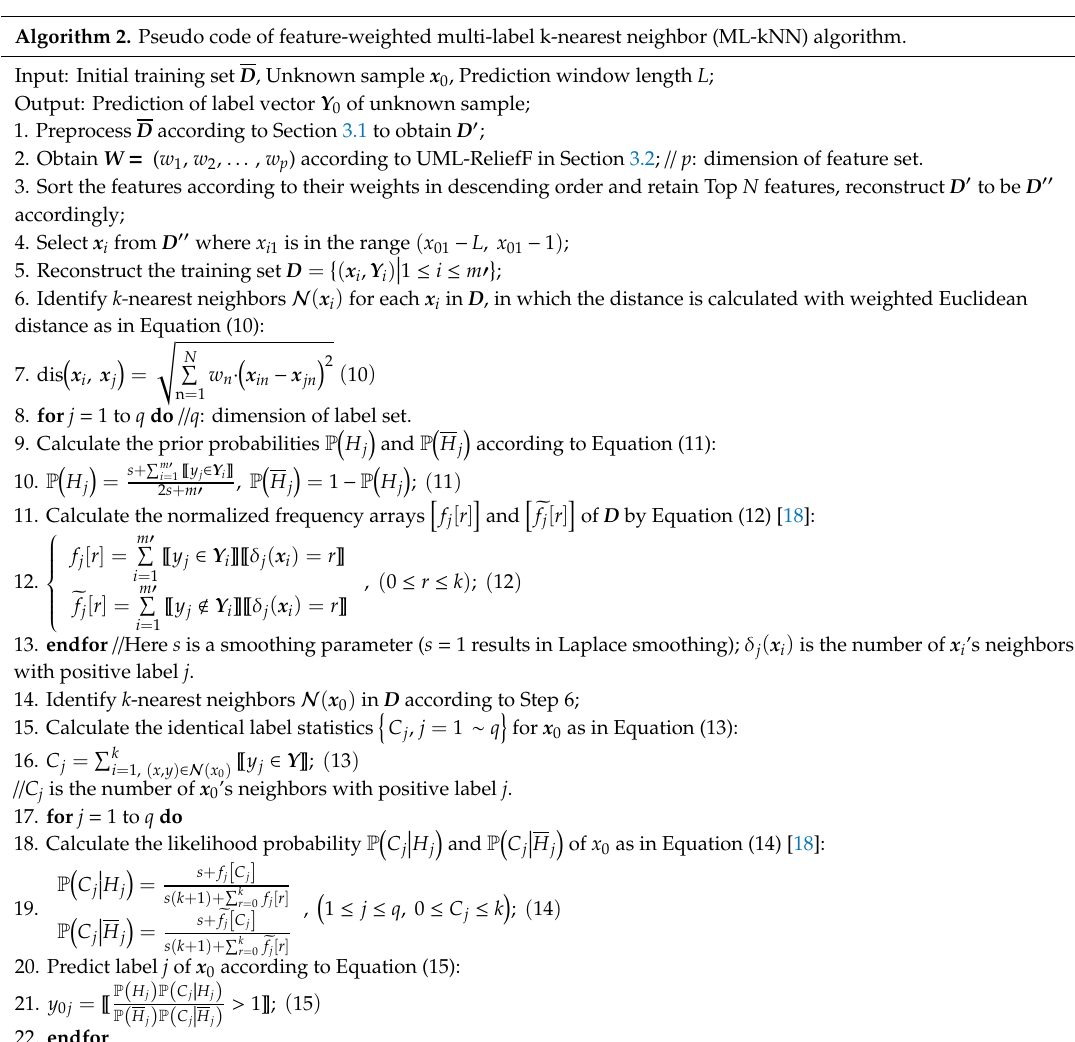
Algorithm 2. Pseudo code of feature-weighted multi-label k-nearest neighbor (ML-kNN)